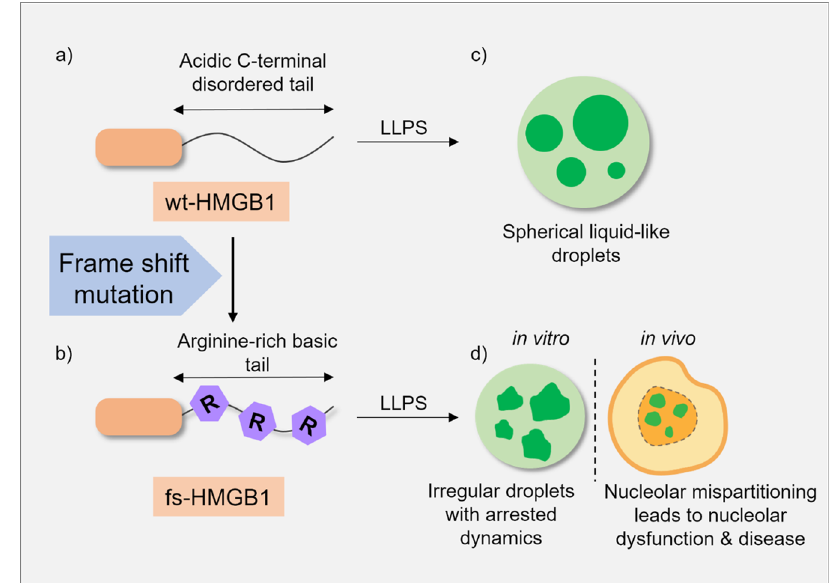
Fig. 1 Schematic representation of HMGB1 phase separation and its link with BPTAS. a Cartoon representation of wt-HMGB1 with ~60 amino acids long acidic disordered tail. b Cartoon representation of fs-HMGB1 in which acidic tail is converted into an arginine-rich basic tail. c wt-HMGB1 phase separates into dynamic, spherical liquid droplets. d Aberrant phase separation of fs-HMGB1 produces dynamically arrested droplets both in vitro & in vivo. Credit: Sumangal